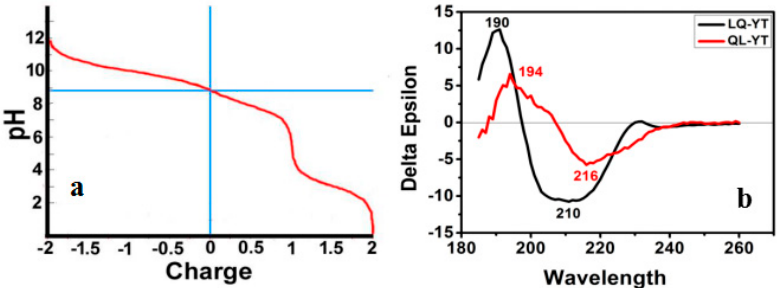
Figure 2. ( a ) Overlapped titration curves for the LQ-YT and QL-YT 14-mer peptides; ( b ) CD spectra of the LQ-YT and QL-YT 14-mer peptides.